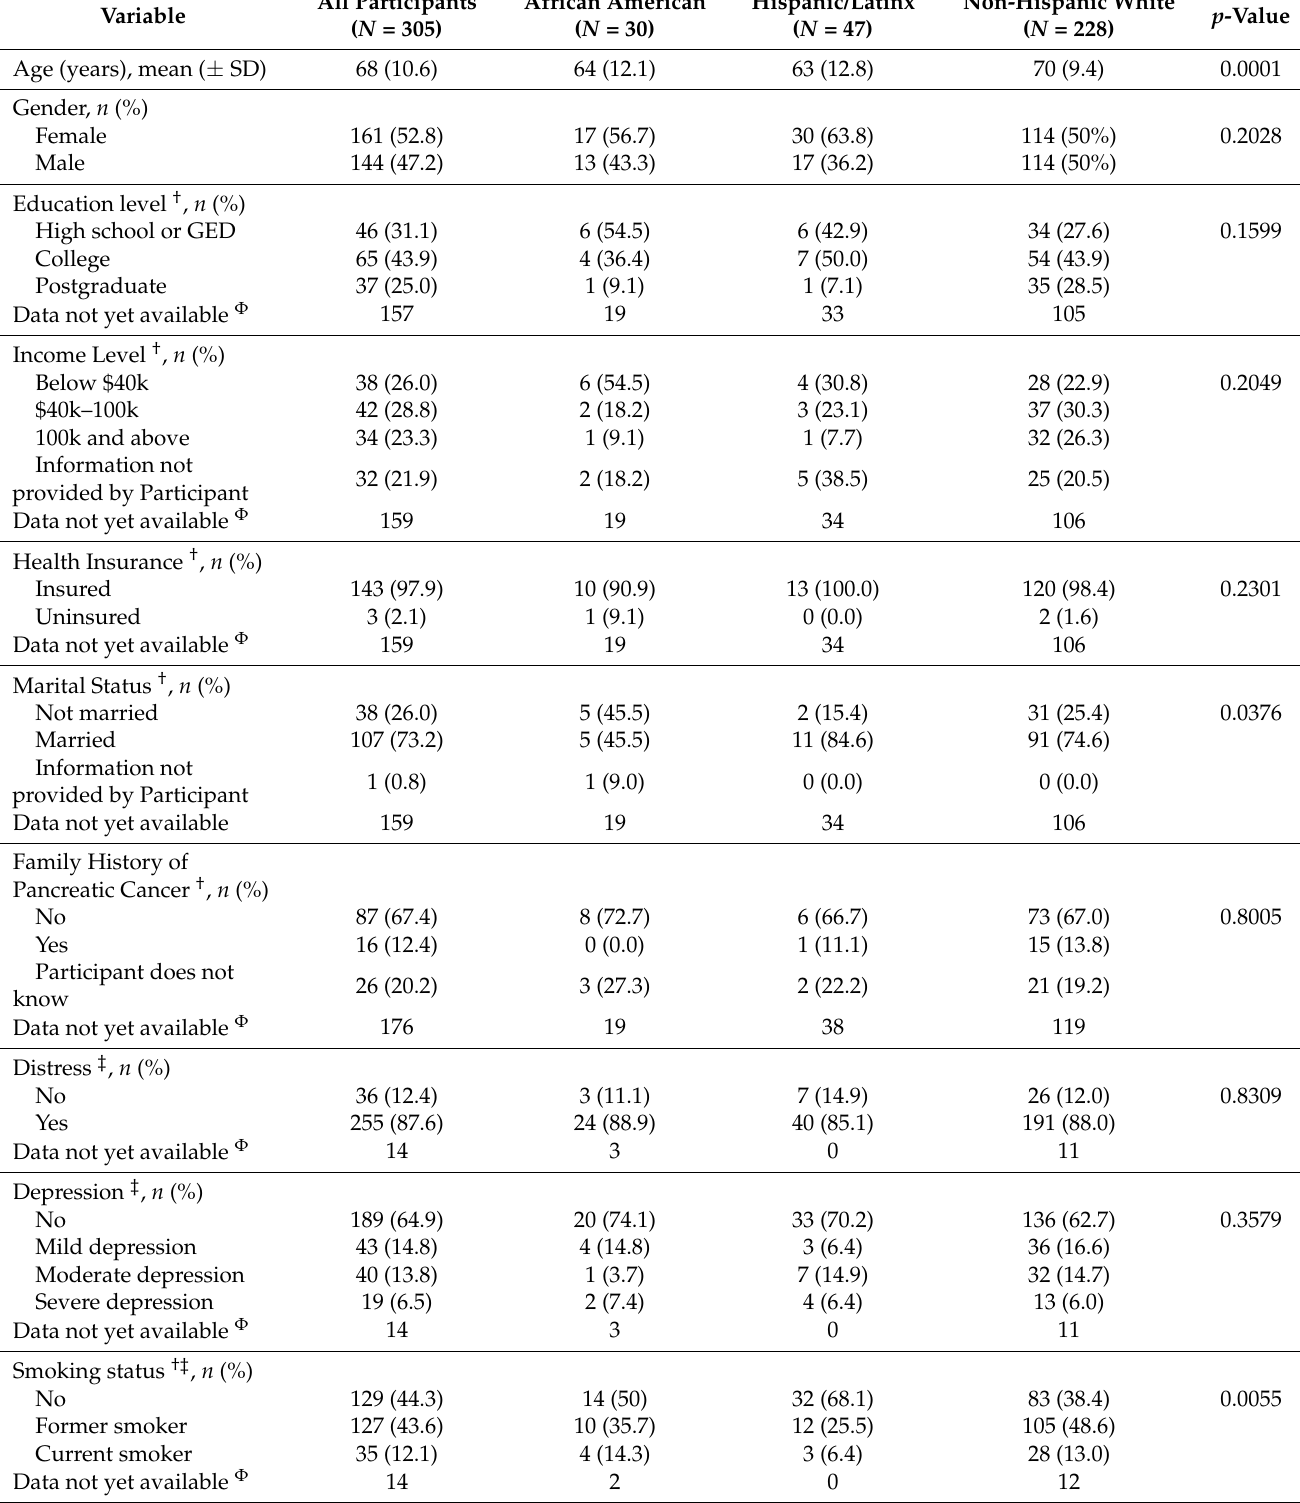
Table 4. Baseline demographic and clinical characteristics of Florida Pancreas Collaborative study participants, by